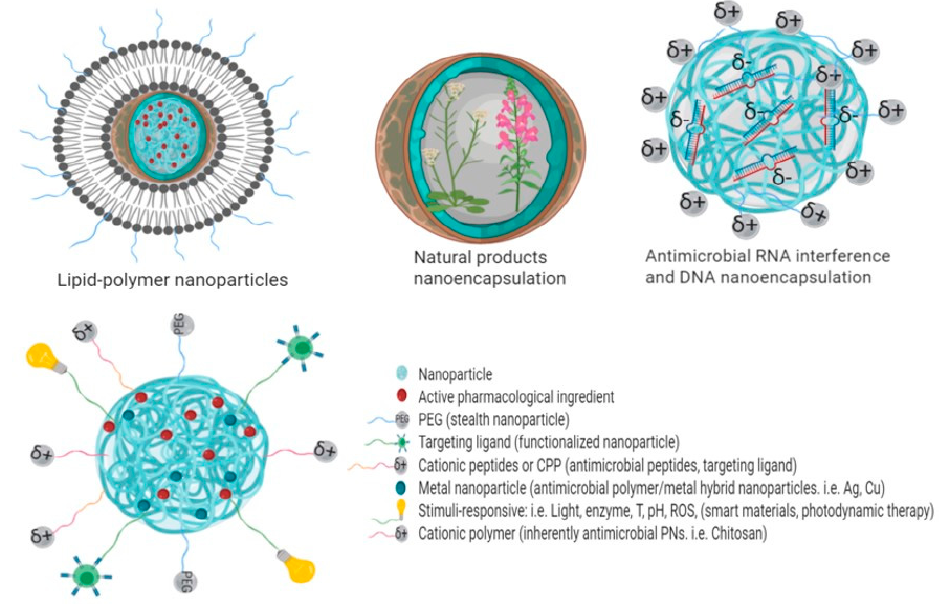
Figure 5. Novel approaches to antimicrobial therapy to attack microorganism resistance.